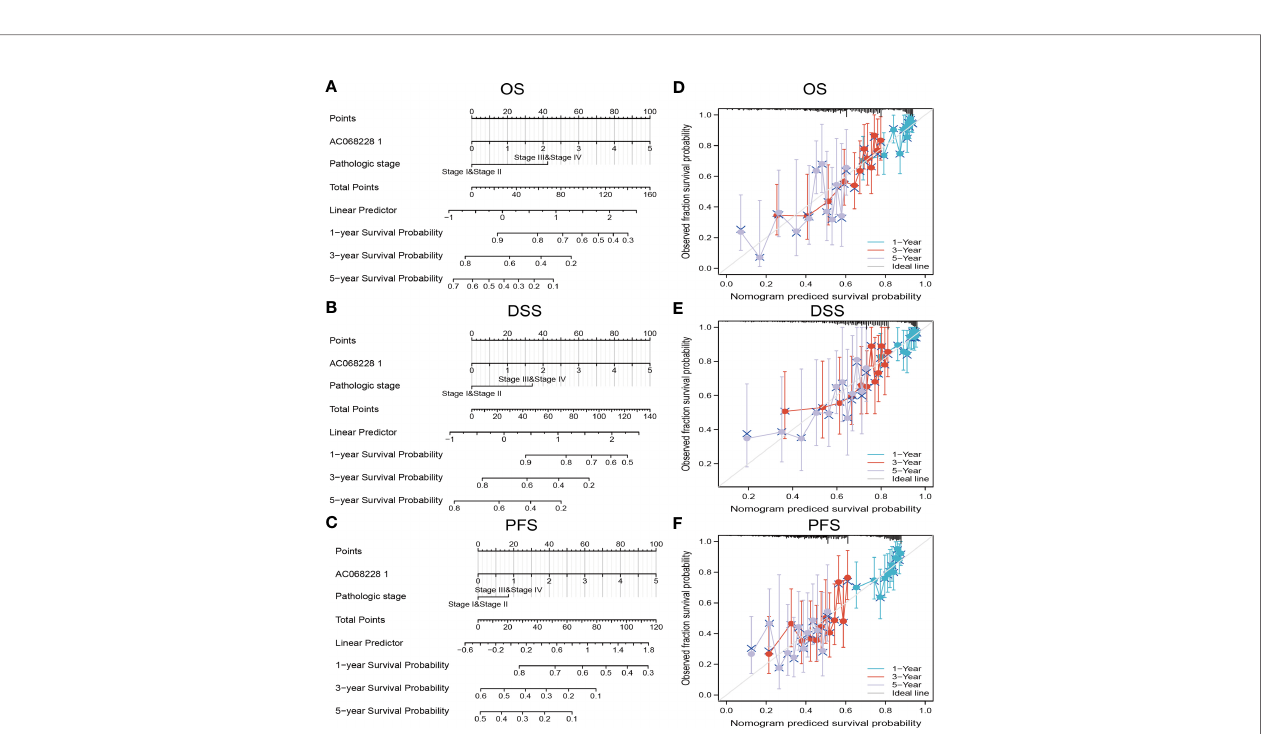
FIGURE 5 | Construction and performance validation of the AC068228.1-based nomogram for lung adenocarcinoma patients. Nomogram used to predict overall survival, disease-free survival, and progression-free survival of lung cancer patient (A – C) . The calibration curve and Hosmer – Lemeshow test of nomograms in the TCGA-lung adenocarcinoma cohort for (D) overall survival, (E) disease-speci fi c survival, and (F) progression-free